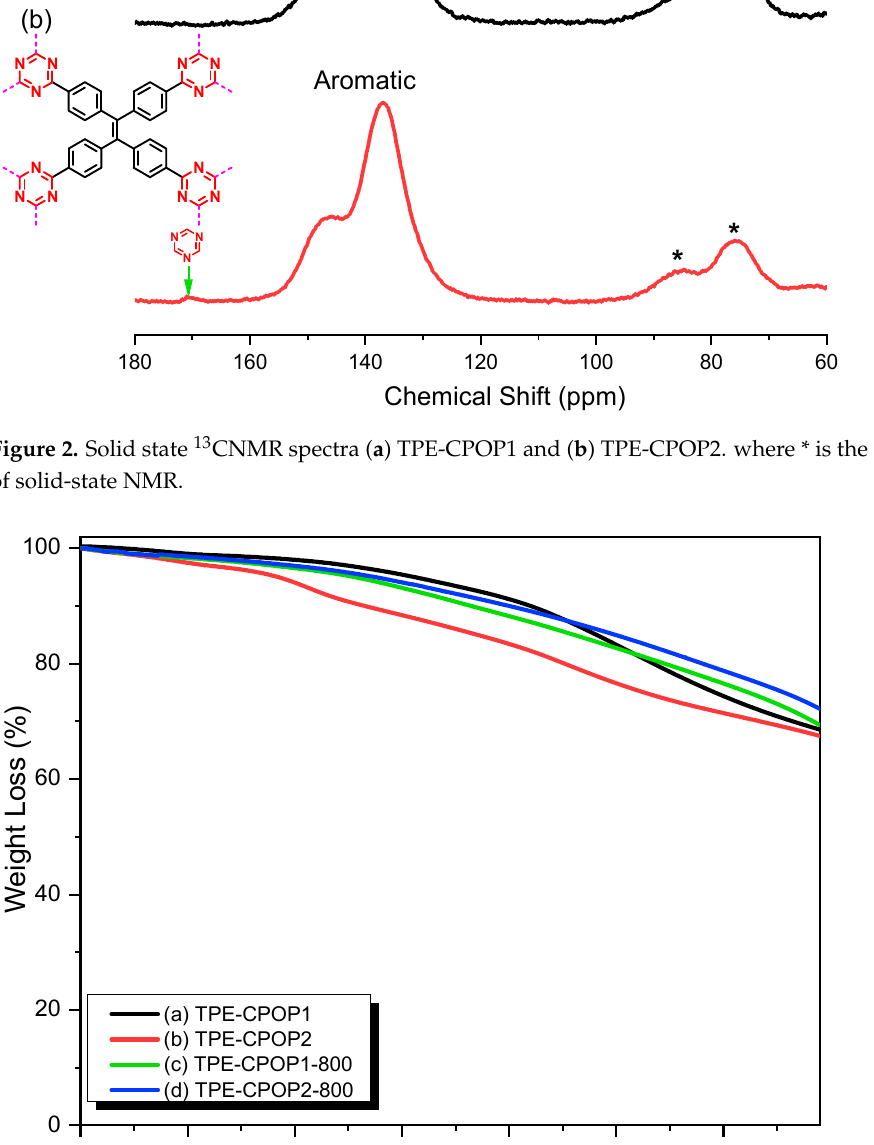
Table 1. Thermal stability and porosity properties of TPE, TPE-CPOP1, TPE-CPOP2, TPE-CPOP1- 800, and TPE-CPOP2-800.